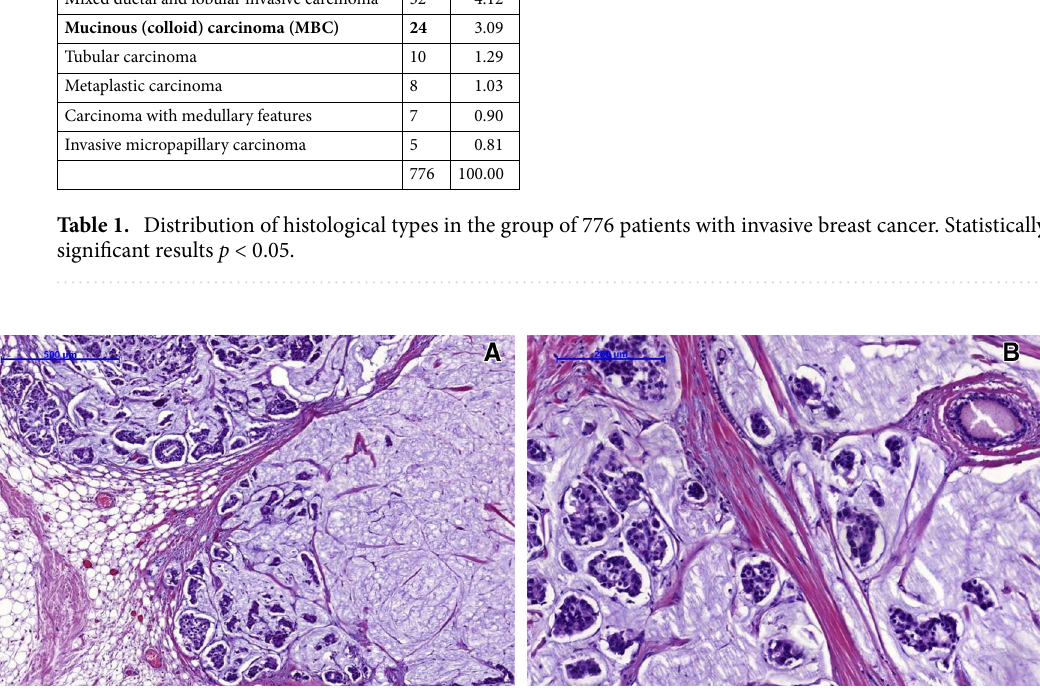
Figure 1. Histopathological image of pure mucinous breast cancer (PMBC) (grade 2, H&E)—characteristic cancer cells “nests” floating in abundant extracellular mucus ( A low magnification; B high